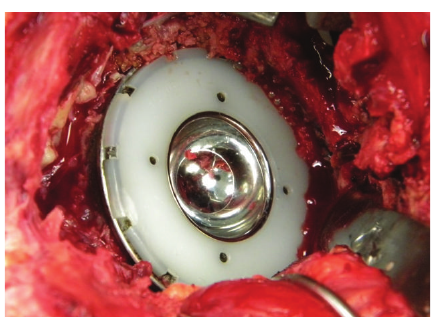
Figure 6: Metasul liner (removed).